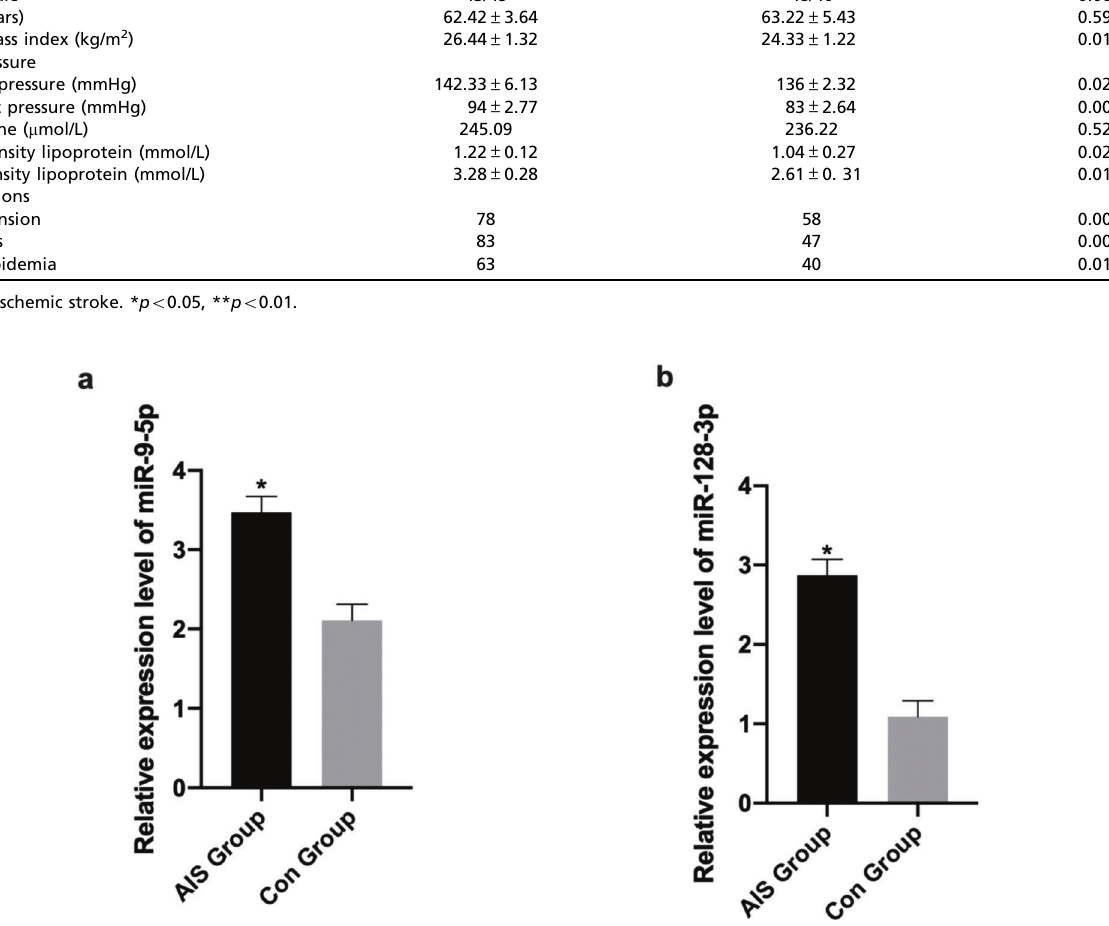
Figure 2 - Comparison of serum miR-9-5p and miR-128-3p levels between the AIS and control groups. a) Serum miR-9-5p levels. b) Serum miR-128-3p levels. * p o 0.05.